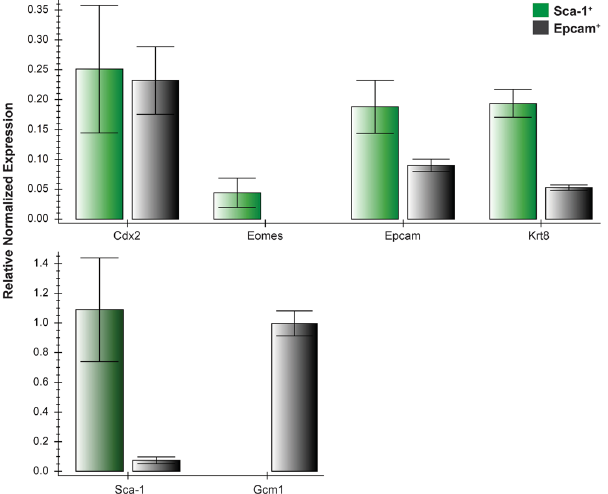
Figure 7. Sca-1 + and Epcam + cells isolated from mouse placentae at E11.5 expressed the trophoblast marker, Krt8 by qRT-PCR. These cells also expressed other known markers of trophoblast, including Cdx2, Eomes and Epcam . Epcam was expressed in both Sca-1 + and Epcam + cells however Sca-1 was only detected in Sca-1 + cells. The syncytiotrophoblast marker, Gcm1 , was detected only in Epcam +